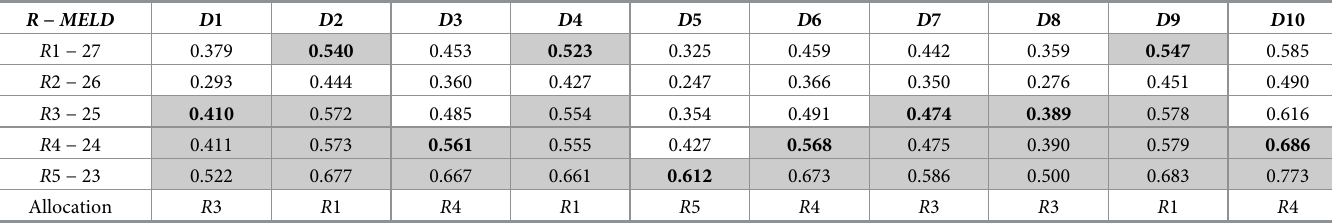
Table 6. First simulation of D-R allocation by the best LR model (recipients MELDs 23 − 27). R − MELD D 1 D 2